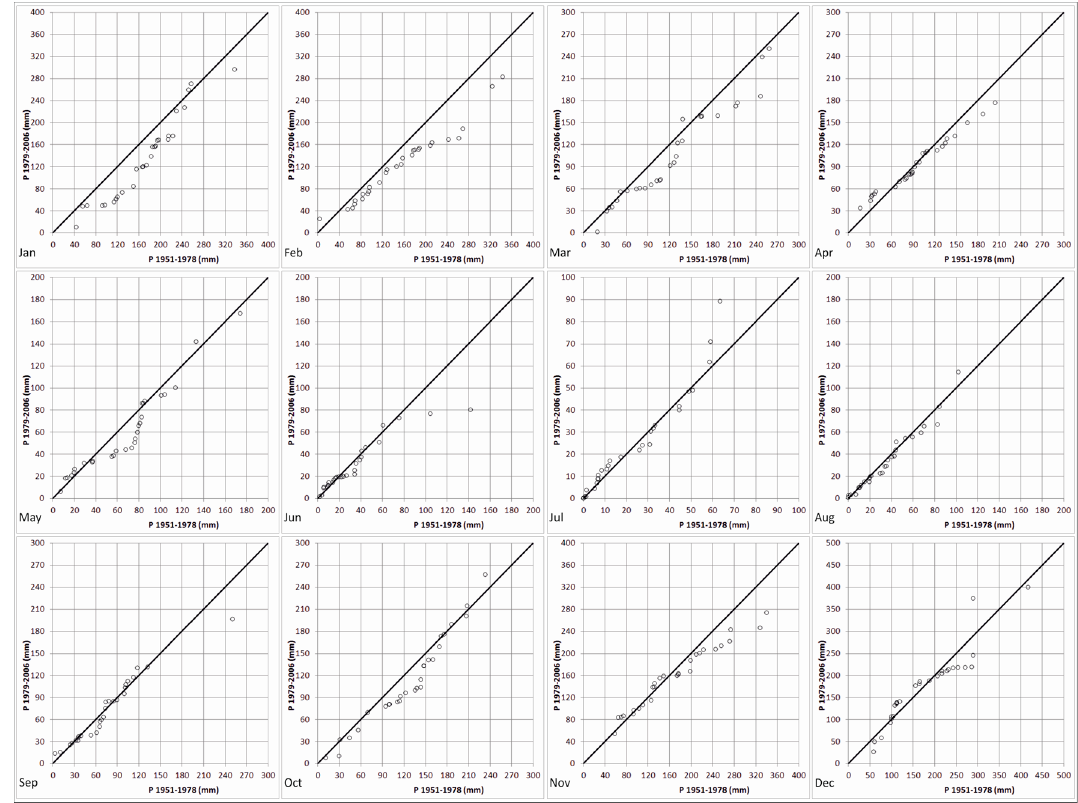
Figure 5. Results of the ITA method for the Rainfall Zone T1 for the period